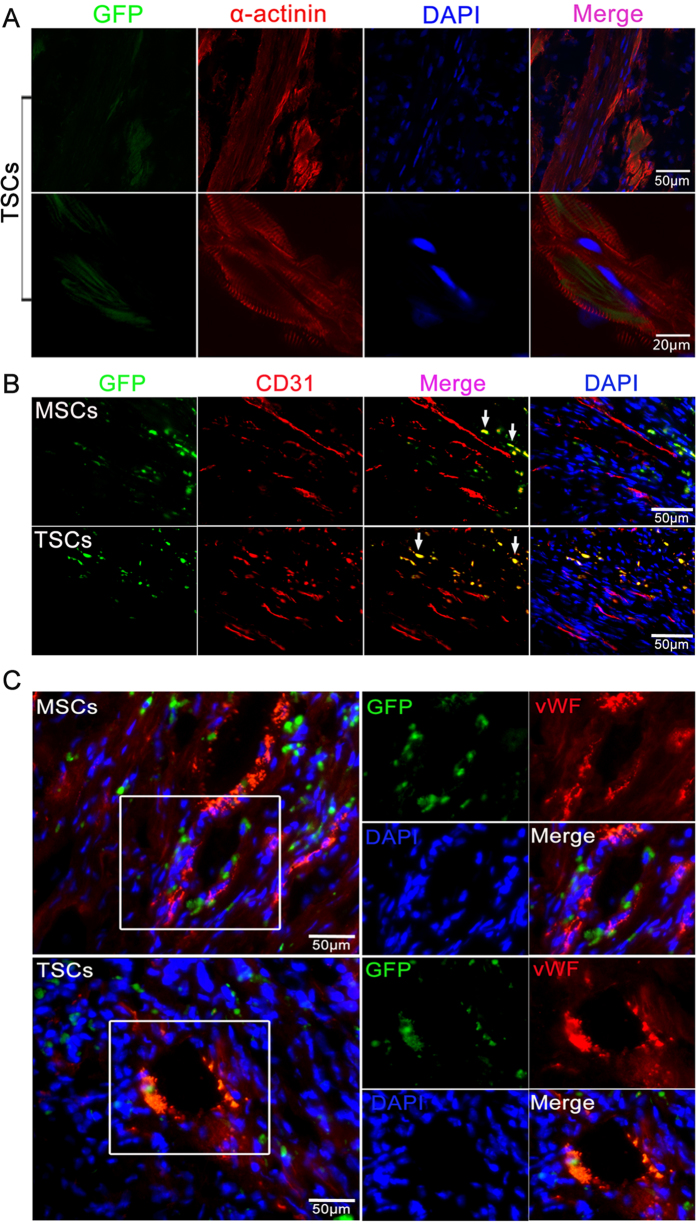
Transdifferentiation of TSCs and MSCs in vivo.(A) Confocal imaging of the TSCs-engrafted hearts and fluorescent immunostaining for α-actinin demonstrated evidence for cardiomyocytes differentiation; nuclei were counterstained with DAPI. (B,C) The sections displayed in B and C showed that MSCs and TSCs gave rise to endothelial-like cells by CD31-staining and participated in the formation of the vasculature as assessed by vWF staining in vivo. The arrows in B identifies co-staining of GFP and CD31. The boxed region in C is shown at higher magnification in the right panel. n = 6 for each group.